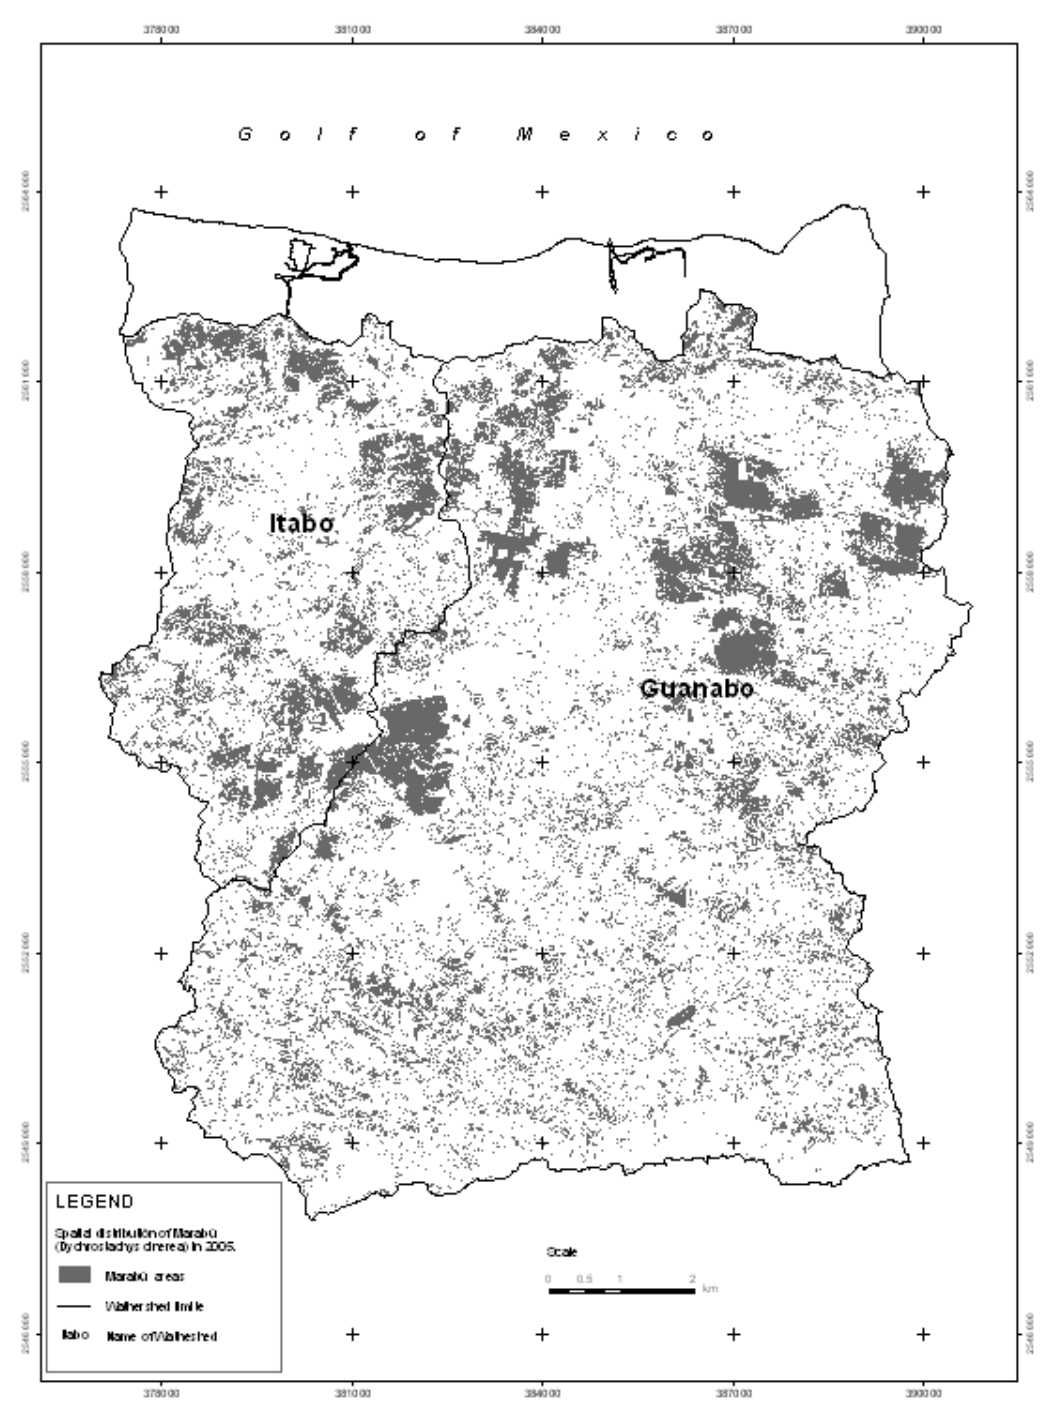
Figure 3. Spatial distribution of Marabú ( Dychrostachys cinerea ) in